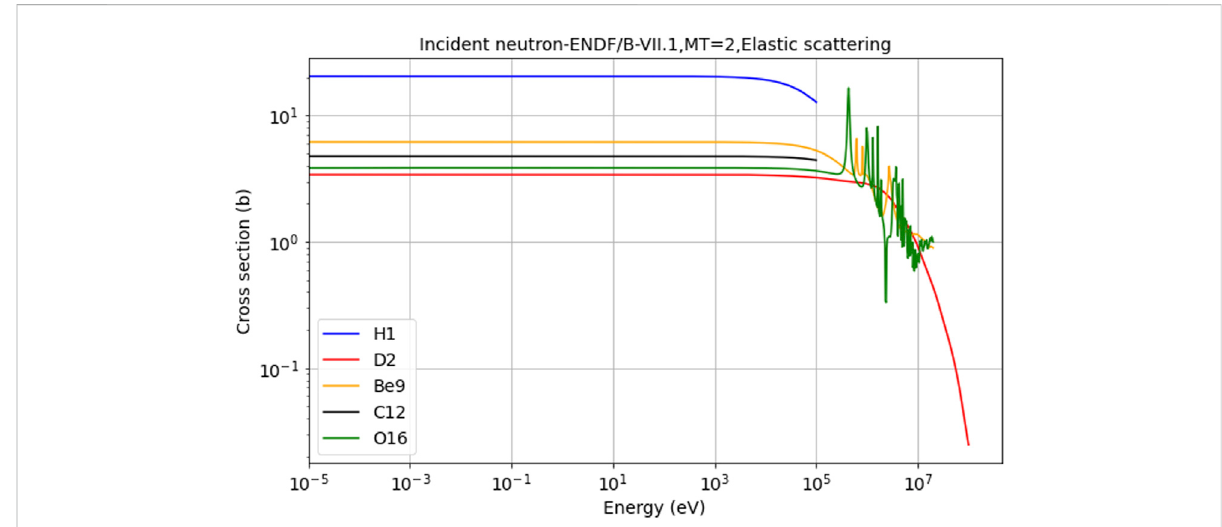
FIGURE 1 Elastic scattering cross-sections (0k) of 1 H, 2 H, 9 Be, 12 C, 16 O versus incident neutron